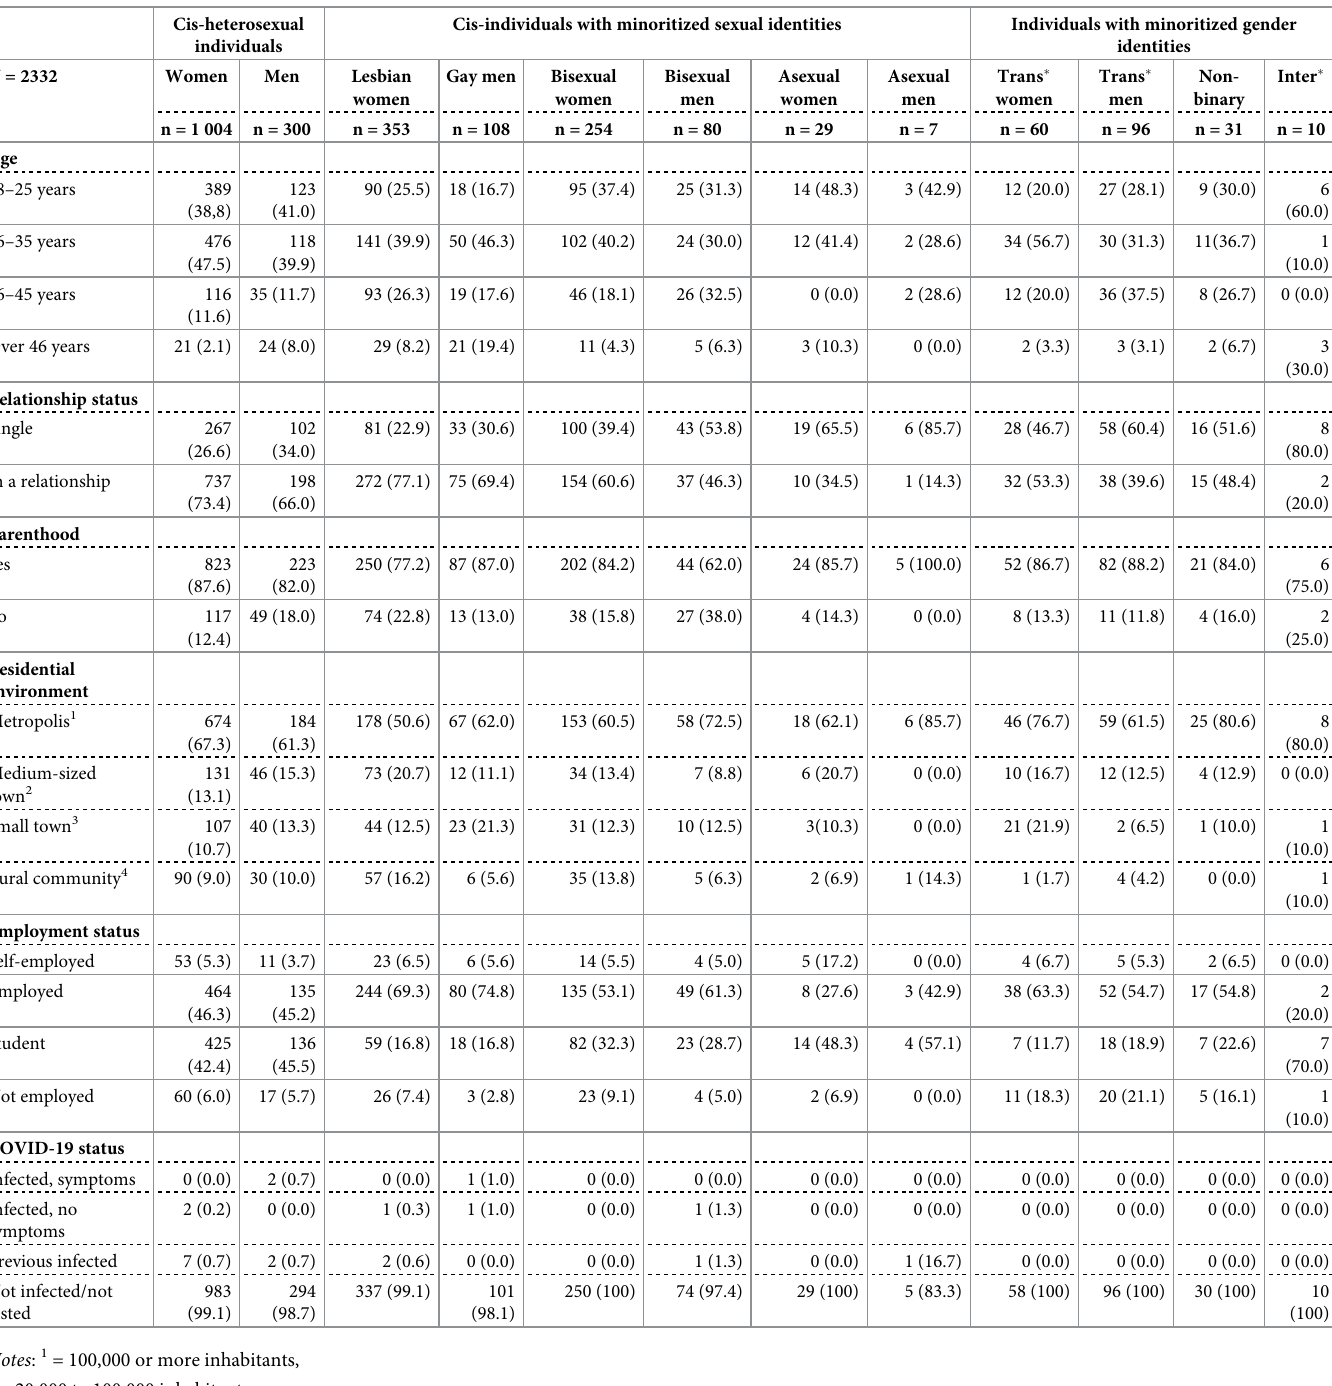
Table 1. Descriptive statistics of the sample; n